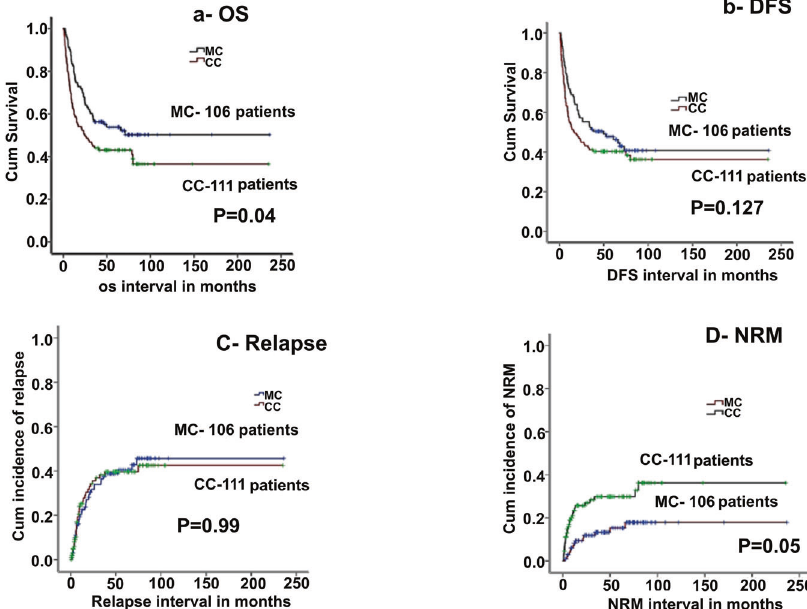
Fig. 1 Comparison of outcomes between MC and CC. a , b The 5-year OS and DFS (CC-complete chimerism, MC mixed chimerism). c , d Relapses and NRM (CC complete chimerism, MC mixed